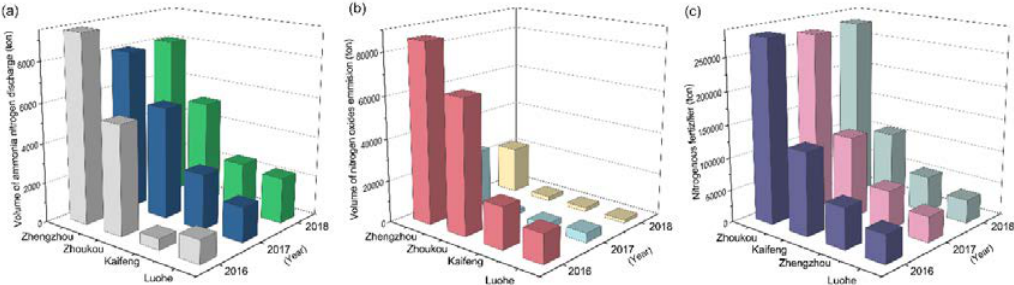
Figure13. Thenitrogensourcesofpollutioninthemaincitiesofthestudyarea. ( a )Pointsourcepollution. Non-point pollution including ( b ) atmospheric source and ( c ) agricultural fertilizer. (Data obtained from statistical yearbooks of the Henan Province. Available online: http://www.ha.stats.gov.cn/tjfw/tjcbw/tjnj/ (accessed on 1 July 2020))